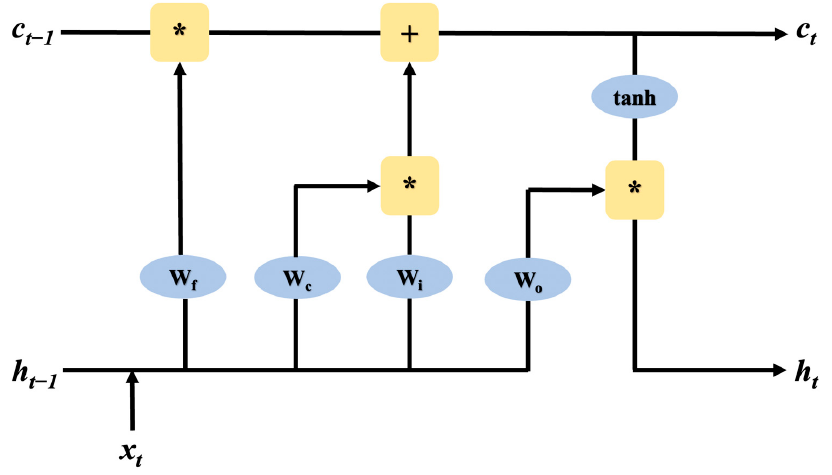
Figure 7. LSTM structure, W f is the forgetting gate, W i is the input gate, W o is the output gate, x t is